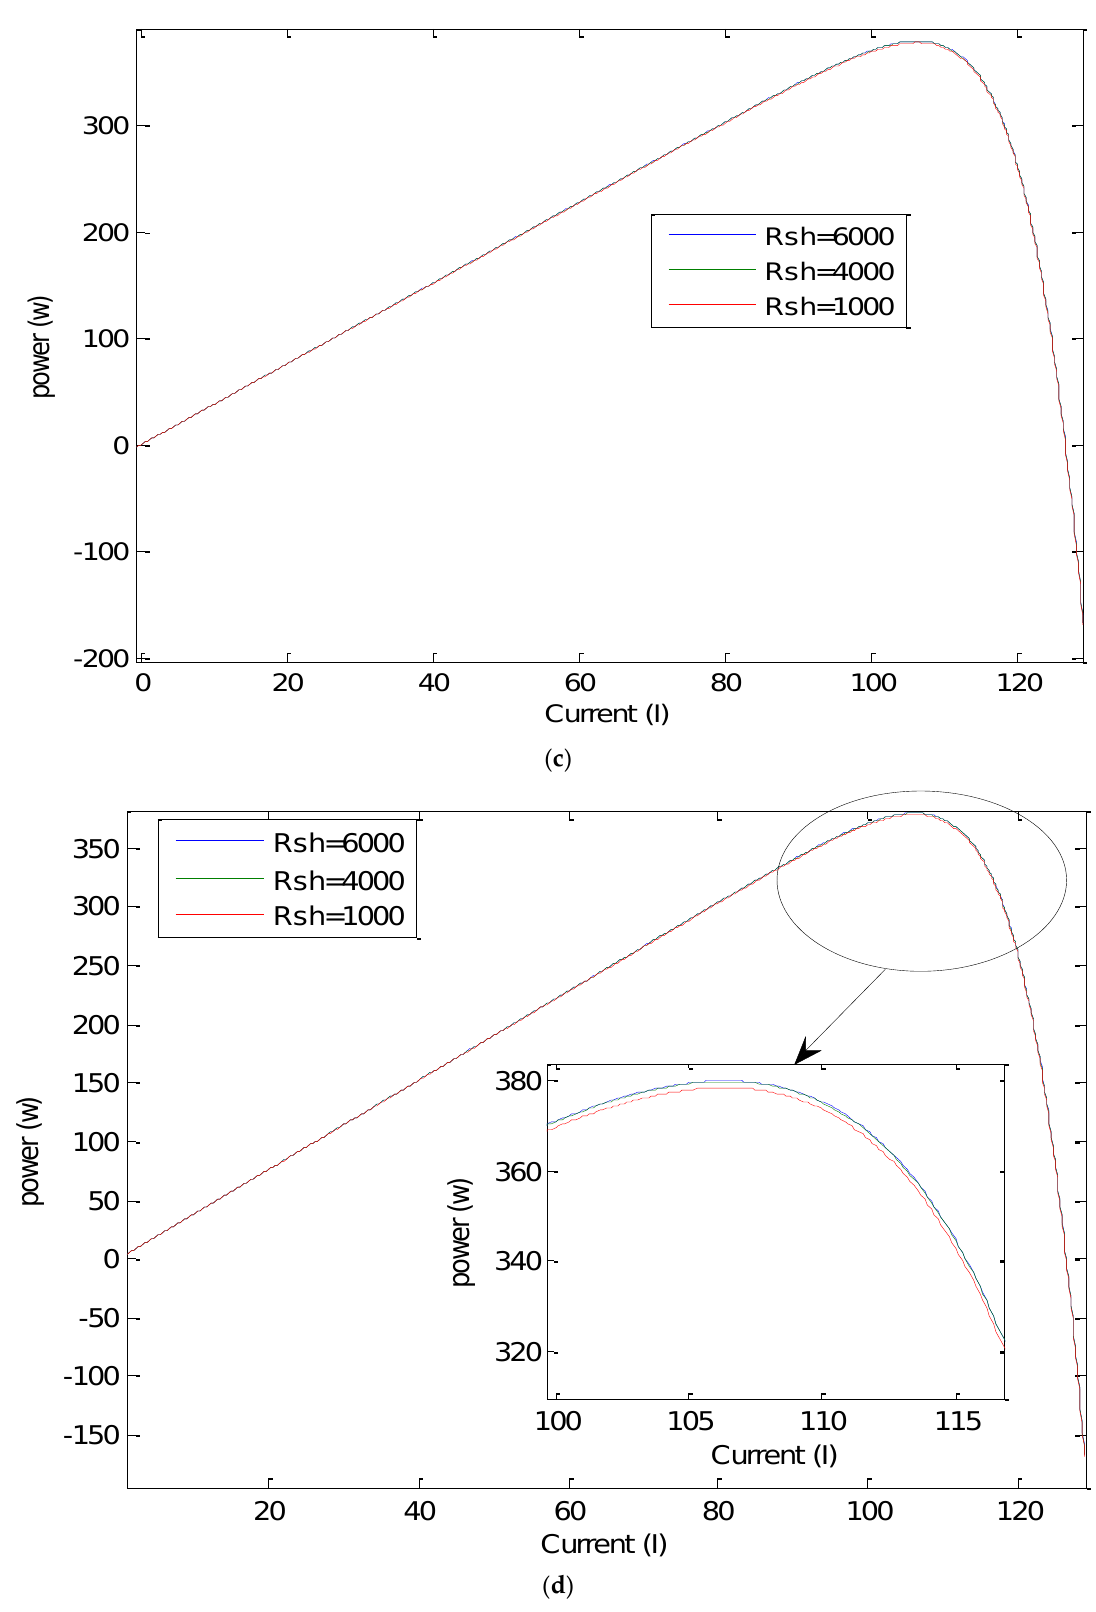
Figure 8. Effect of variation of shunt resistance on characteristic of PV cell: ( a ) I-V ch/s; ( b ) zoom in I-V ch/s; ( c ) P-I ch/s; and ( d ) zoom in P-I ch/s.